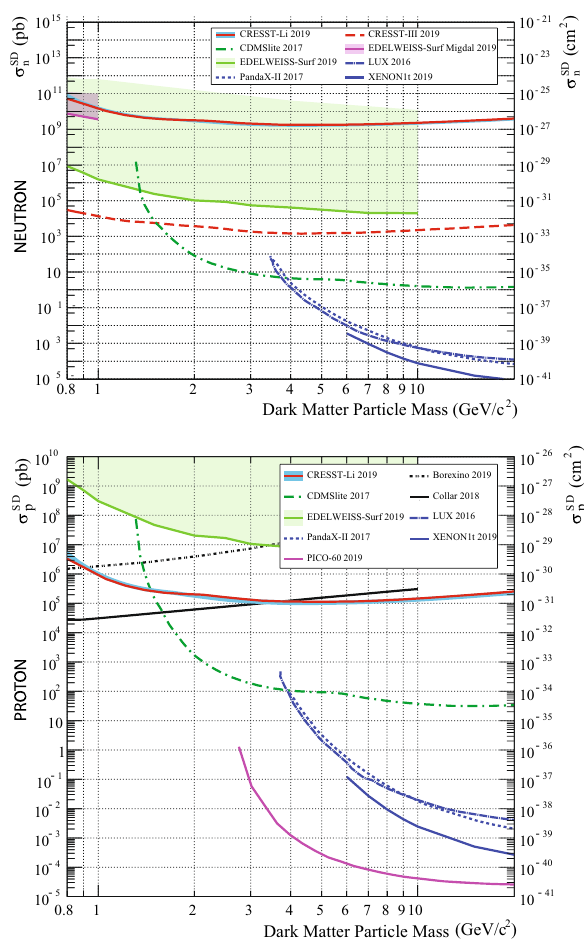
Fig. 4 Top: exclusion limit obtained for neutron-only spin-dependent interactions of dark matter particles with Standard Model particles. The cross section for this kind of interactions is shown on the y axis (pb on the left, cm 2 on the right), while the dark matter particle mass is on the x axis. The result of this work with 7 Li is drawn in solid red with the two-sigma band resulting from statistical uncertainty in solid blue: we reach1 . 06 · 10 − 26 cm 2 at1GeV/c 2 .IndashedredweshowtheCRESST- III[11]limitusing 17 O.Forcomparison,weshowlimitsderivedbyother direct detection experiments: EDELWEISS [32] and CDMSlite [26] using 73 Ge; LUX [27], PandaX-II [30], and XENON1T [29] using 129 Xe + 131 Xe (see legend). Bottom: same, but for proton-only spin- dependent interactions. Our result with 7 Li is depicted in solid red with with the two-sigma band in solid blue, reaching 6 . 88 · 10 − 31 cm 2 at 1 GeV/c 2 . Additionally, we plot limits from other experiments: CDM- Slite[26]andEDELWEISS[32]with 73 Ge;LUX[27],XENON1T[29], and PandaX-II [30] with 129 Xe + 131 Xe; PICO-60 with 19 F [31]; Col- lar [24] with 1 H. Finally, we plot in dotted black a constraint from Borexino data derived in